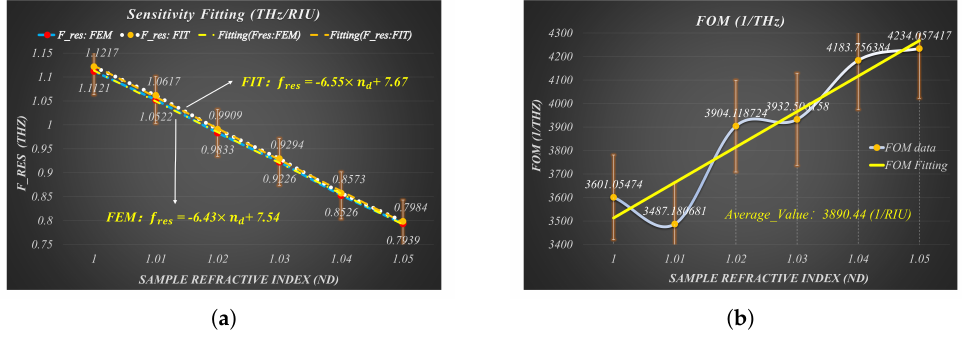
Figure 8. The fitting curves of Sensitivity ( a ) and FOM ( b